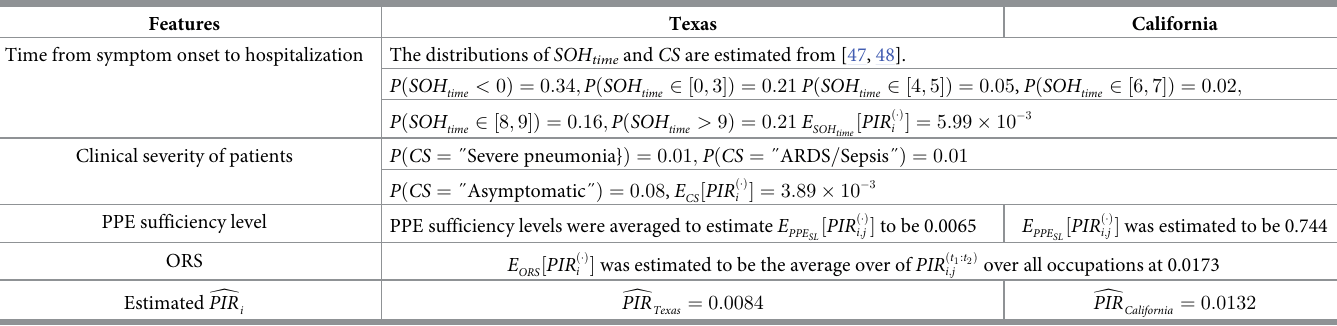
Table 4. Estimated value and distribution of the selected features used in two case studies to estimate the infection risk in Texas and California. Features and CS are estimated from [47, The distributions of SOH time